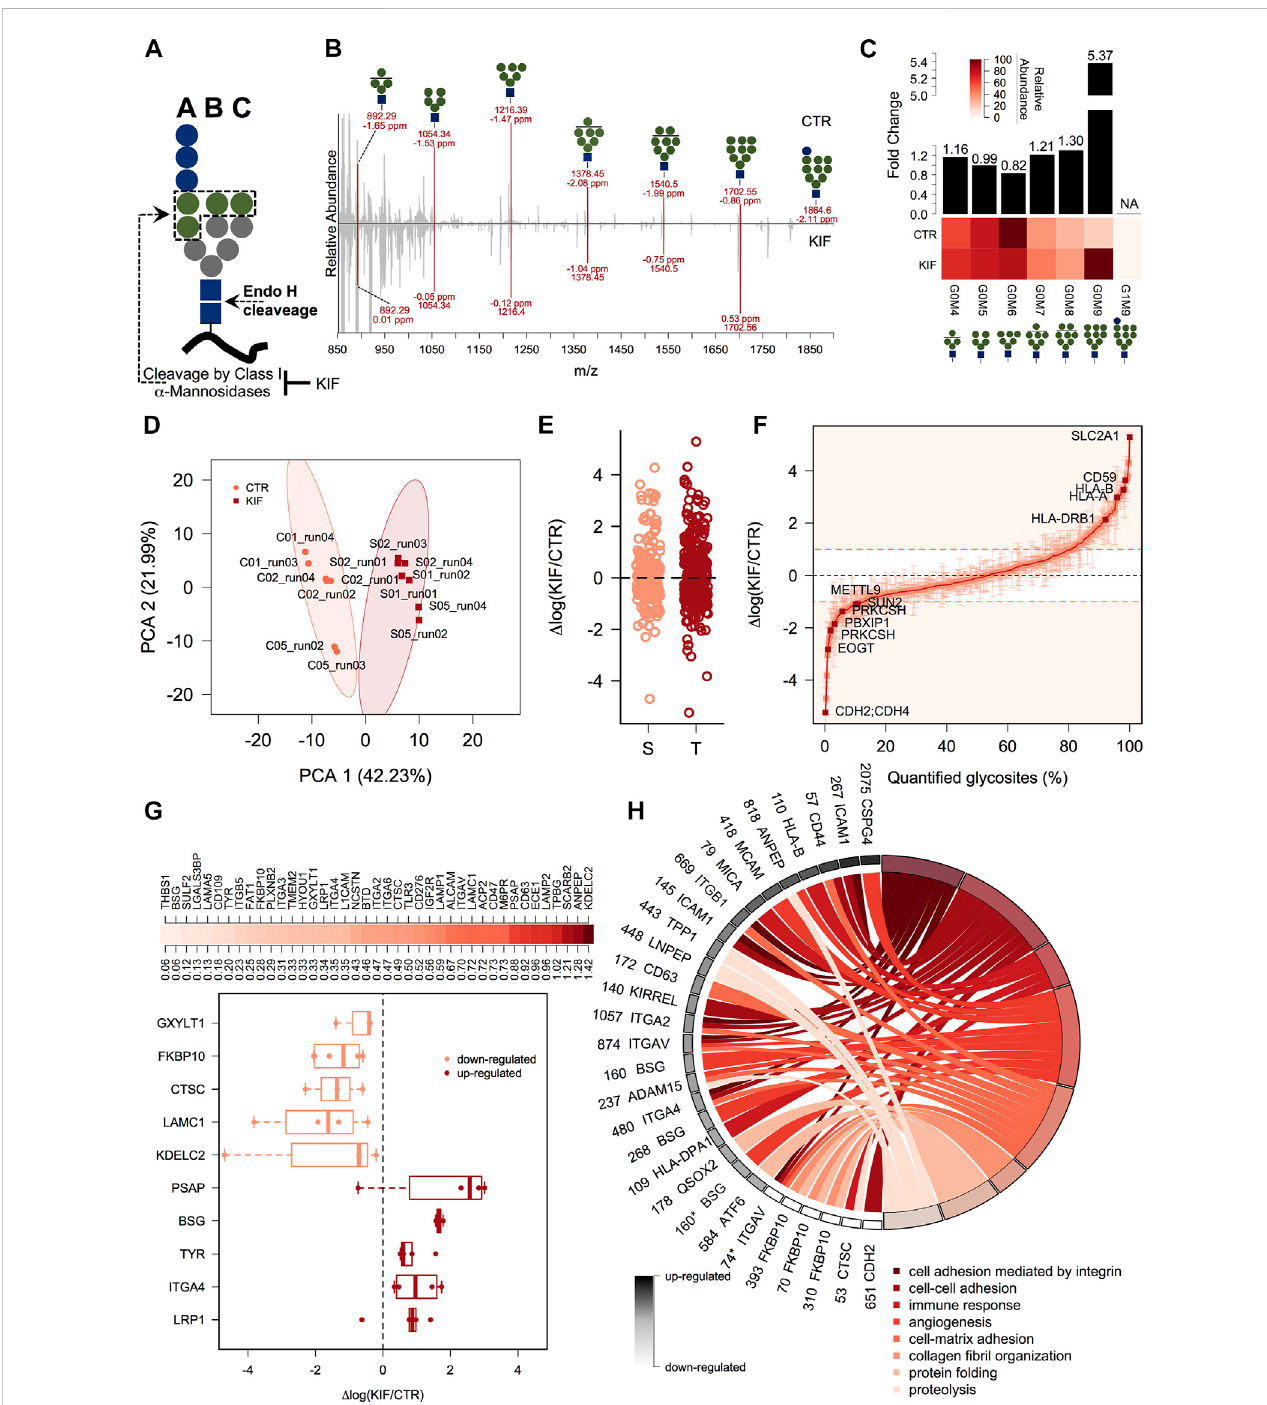
FIGURE 2 gESP analysis of kifunensine treated cells. (A). General structure of the N-linked glycan transferred on N-glycosylated proteins during intracellular glycosylation.Shown are the Endo H cleavage point and thethree main branches. Greencircles denotes α 1,2-linked mannose residueswhich are recognized by class I mannosidases. (B). Mirror plot of the Endo H released carbohydrate structures from CTR and KIF treated cells. All major classes (G0M9 - G0M4) of released N-glycans were found in both conditions as sodium adducts. Shown are the m/z and mass accuracy from both conditions. (C). Analysis of the relative abundance for the major N-glycans identi fi ed in (B). The lower heat map displays the relative abundance of the identi fi ed classes and upper bars denotecalculatedfoldchangebetweenKIFandCTRcells. (D). PCAanalysisofthecorrespondingglycositesidenti fi edinthetwoconditions. (E). Analysisofthe quanti fi edglycositescontainingSerorThr. Noapparentdifferenceswereobservedforthetwocategories. (F). Distributionattheglycositelevel ofthelog fold changes between KIF and CTR cells. Points are median of biological triplicates and error bars denote SEM. Several top up-regulated and down-regulated glycosites are shown with their corresponding gene name. (G). Upper-panel: Distribution of calculated glycoprotein SEM across the identi fi ed glycosites. Lower-panel: Boxplot indicating top up-/down-regulated glycoproteins in KIF treated cells. Points denote each quanti fi ed glycosite. Only glycoproteins with at least three quanti fi able glycosites were considered. (H). Biological pathway Gene Ontology (GO) analysis of the quanti fi ed glycoproteins. Shown are the gene names and glycosylation position with their corresponding up-/down-regulation in black to white colors and their associated biological processes in shades from dark to light-red. It can be observed the segregation of different biological processes with the estimated fold-change. Glycosylation positions refer to the UniProt reviewed entries of the corresponding gene names. * designates a dHexHexNAc site.